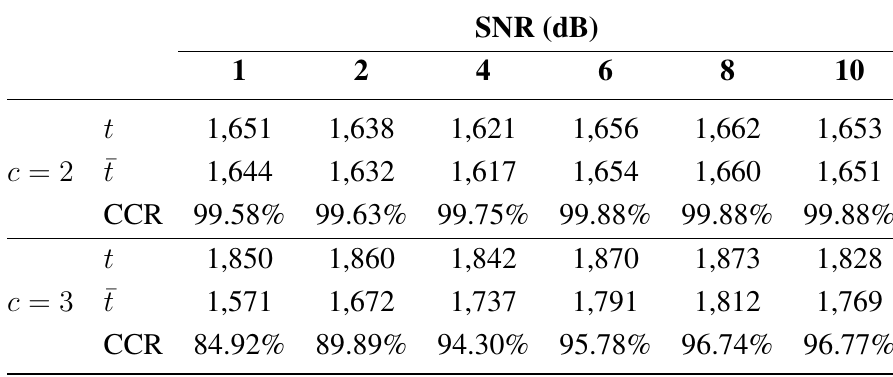
Table 2. Classification correct rates (CCRs) of the proposed architecture for the spike sorting with different signal-to-noise (SNR)